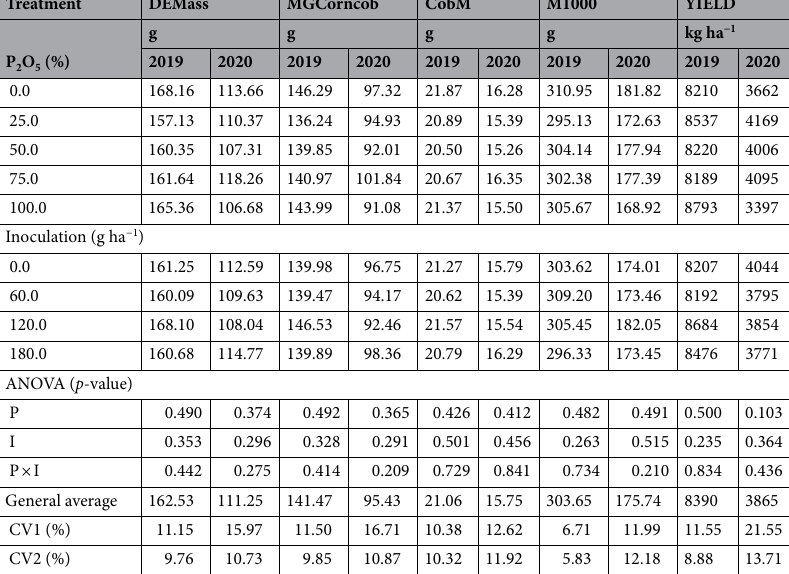
Table 4. Dehusked corncob mass (DEMass), the mass of grains per corncob (MGCorncob), Cob mass (CobM), the mass of thousand grains (M1000), and grain yield (YIELD) as a function of amounts of added P 2 O 5 and inoculant containing Rhizophagus intraradices . CV: coefficient of variation (%).